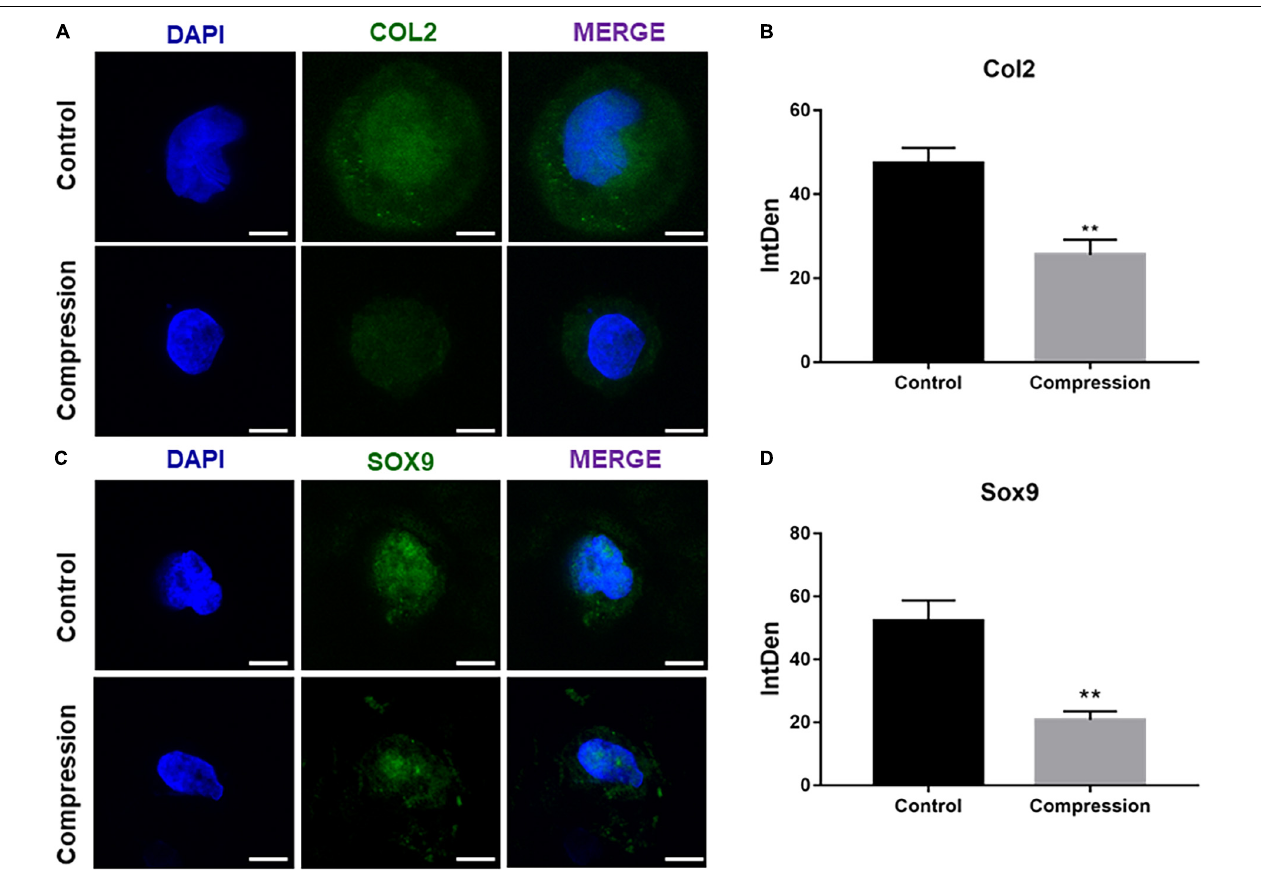
FIGURE 4 | (A,C) Immunofluorescence staining of COL2 and SOX9 after dynamic compression without preculture at day 28. Scale bars = 10 µ m. (B,D) Integrated density of COL2 and SOX9 by ImageJ. Results are presented as the mean ± S.D. ** P < 0.01. COL2, collagen type II; SOX9, SRY-box transcription factor 9.